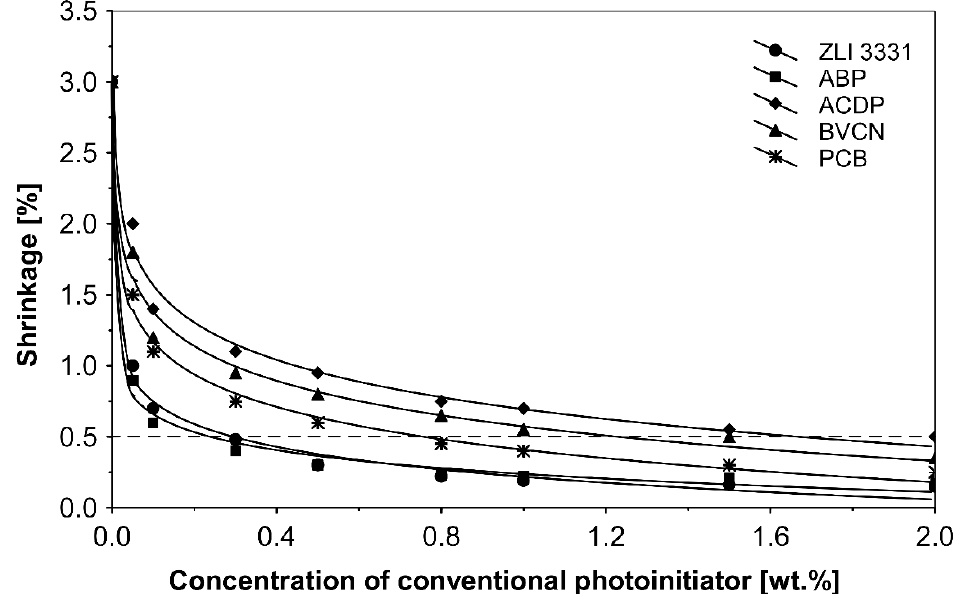
Figure 5. Shrinkage of the acrylic PSAs containing copolymerizable and the additional photoinitiators after the crosslinking using UV radiation.